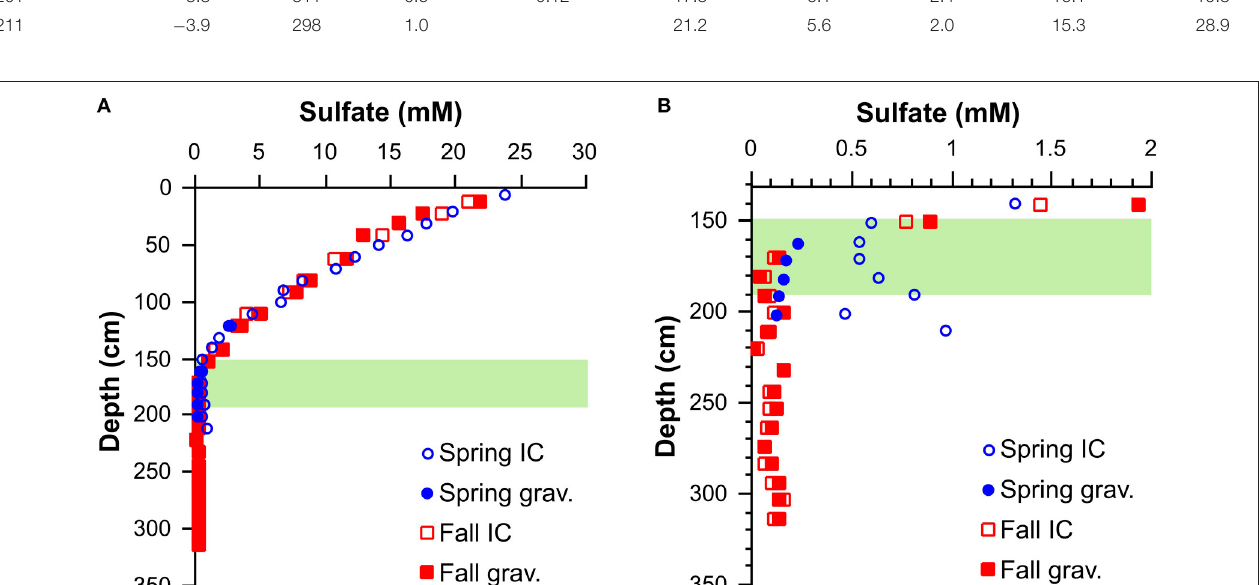
composition of meteoric water in Denmark ( − 8‰; Jørgensen and Holm, 1994) and to the isotope composition of water from two wells at Stautrup Waterworks near Aarhus ( − 7.95 to − 8.65‰; Jørgensen and Holm,